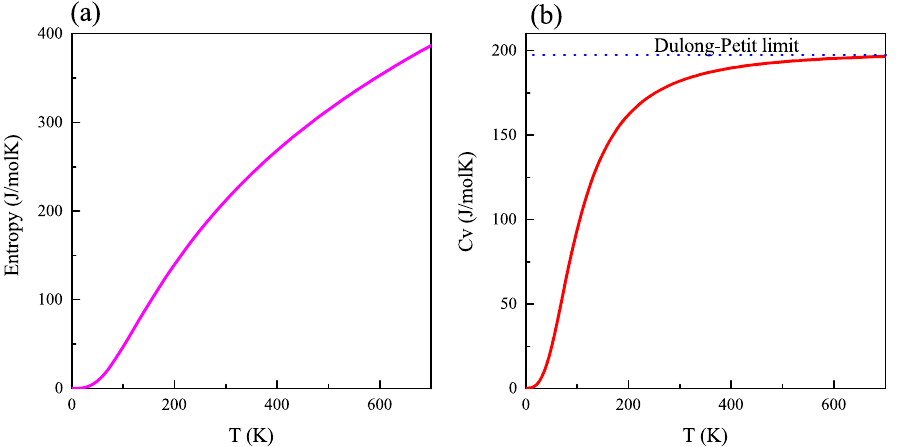
Figure 4. ( a ) Entropy and ( b ) constant-volume heat capacity as a function of temperature in bulk kesterite Cu 2 ZnGeS 4